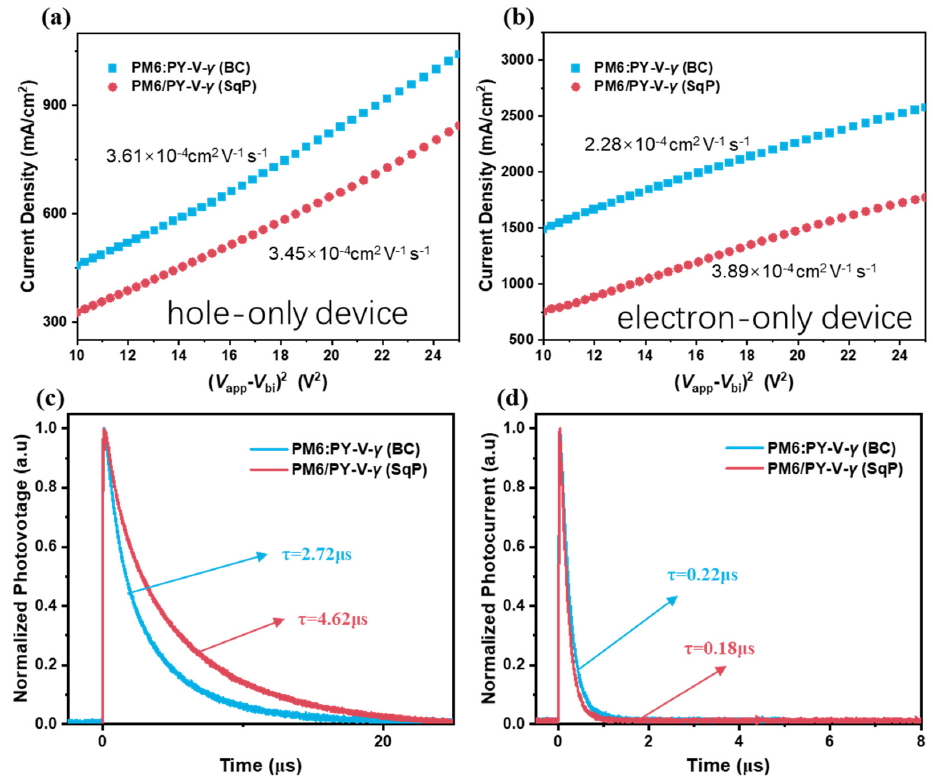
Figure 4. J - V 2 curves of hole-only devices ( a ) and electron-only devices ( b ) for SCLC mobility eval- uation. TPV ( c ) and TPC ( d ) decays of the BC and SqP devices. evaluation. TPV ( c ) and TPC ( d ) decays of the BC and SqP